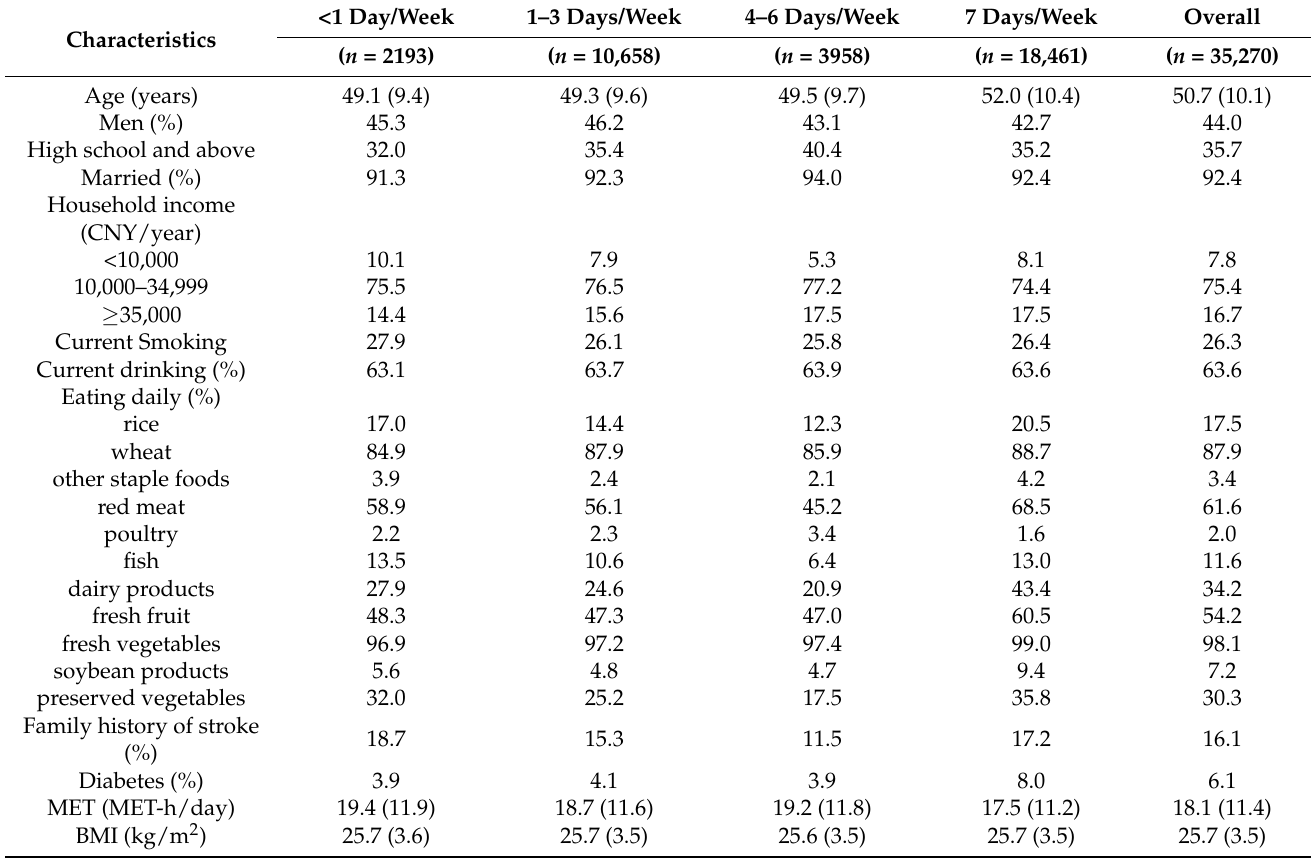
Table 1. Basic characteristics of study participants by frequency of egg consumption.